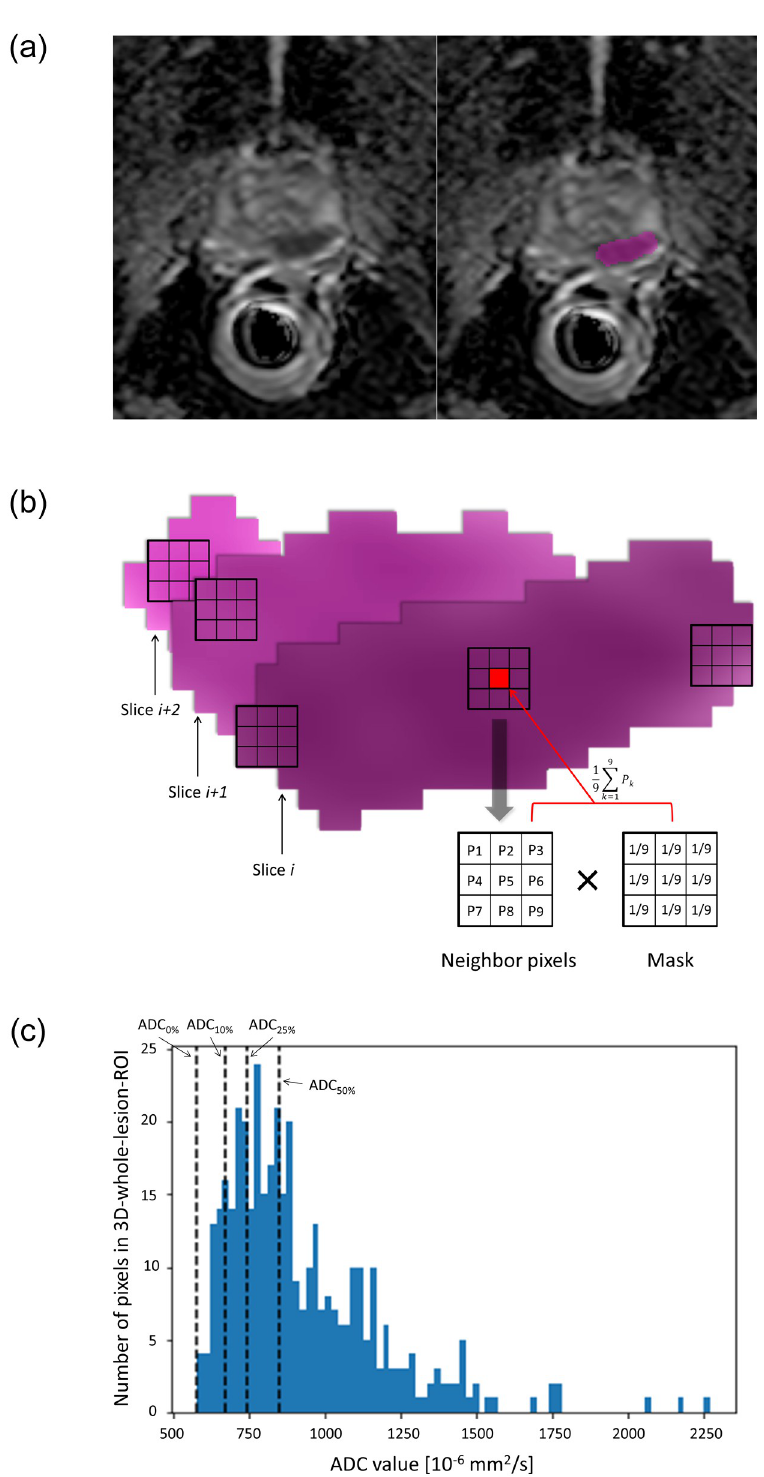
Fig 2. Computed-based calculation for ADC values of lesion. (a) Prostate cancer (Gleason score 4+3) in the left posterior peripheral zone of a 72-year-old man (left). On the ADC image, 3D-whole-lesion-ROI was placed encompassing the entire area of visually low ADC (right). (b) Schematic illustration of multiple overlapping 2D-small- ROIs (9 pixels), which were automatically generated within the 3D-whole-lesion-ROI. The kernel mask was used to average the neighbor pixels to the center pixel. The reference value was determined as the minimum of the multiple